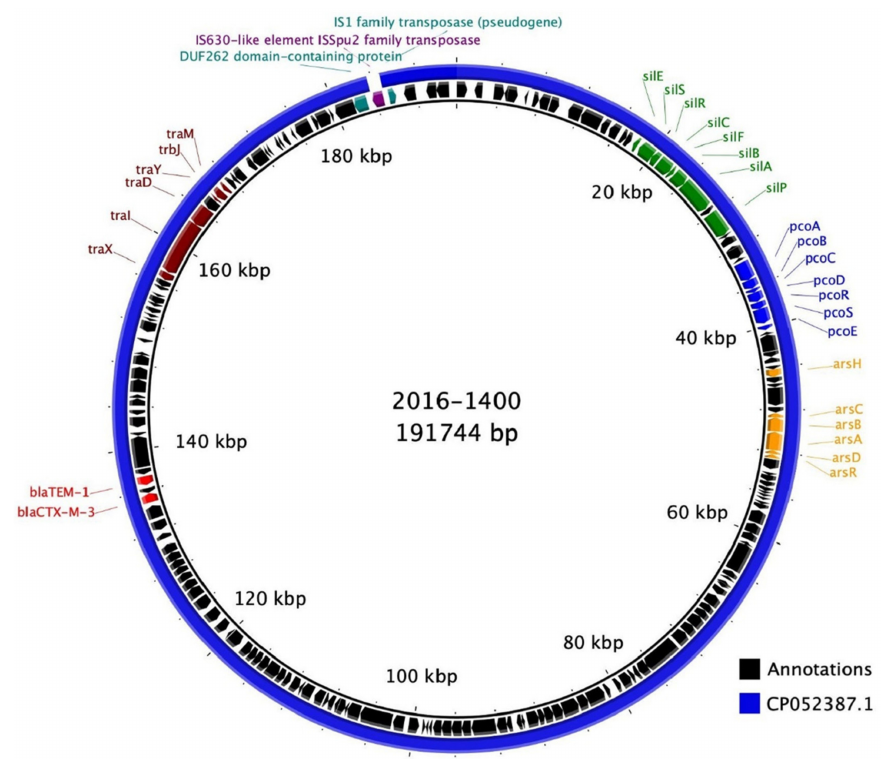
Figure 2. BLAST Ring Image Generator (BRIG) comparison of the K. pneumoniae sensu stricto 2016-1400 plasmid (accession number CP065035) and the plasmid from K. pneumoniae strain C17KP0055